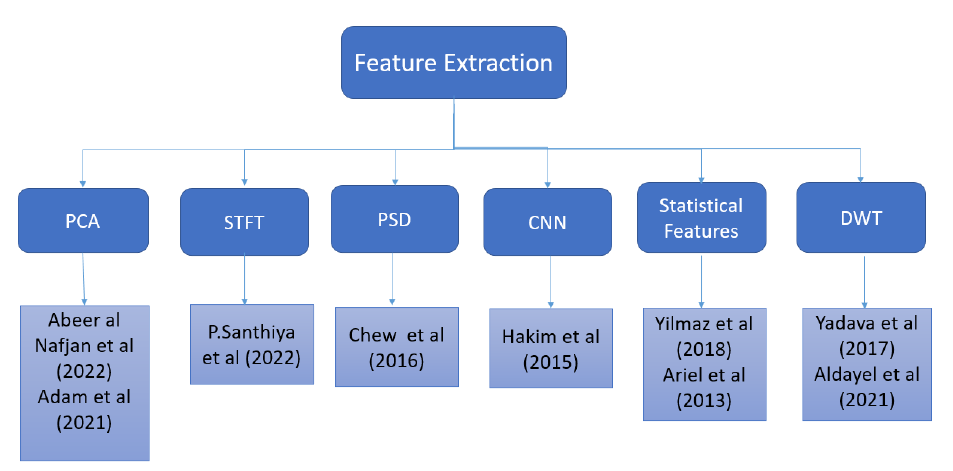
Figure 2. Feature extraction of EEG signals in the